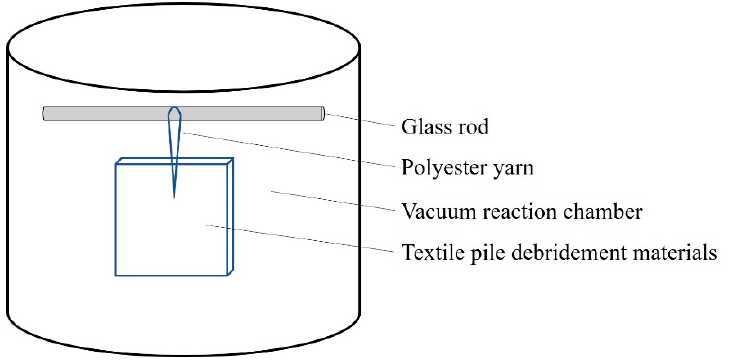
Figure 1. Illustration of the plasma treatment setup.